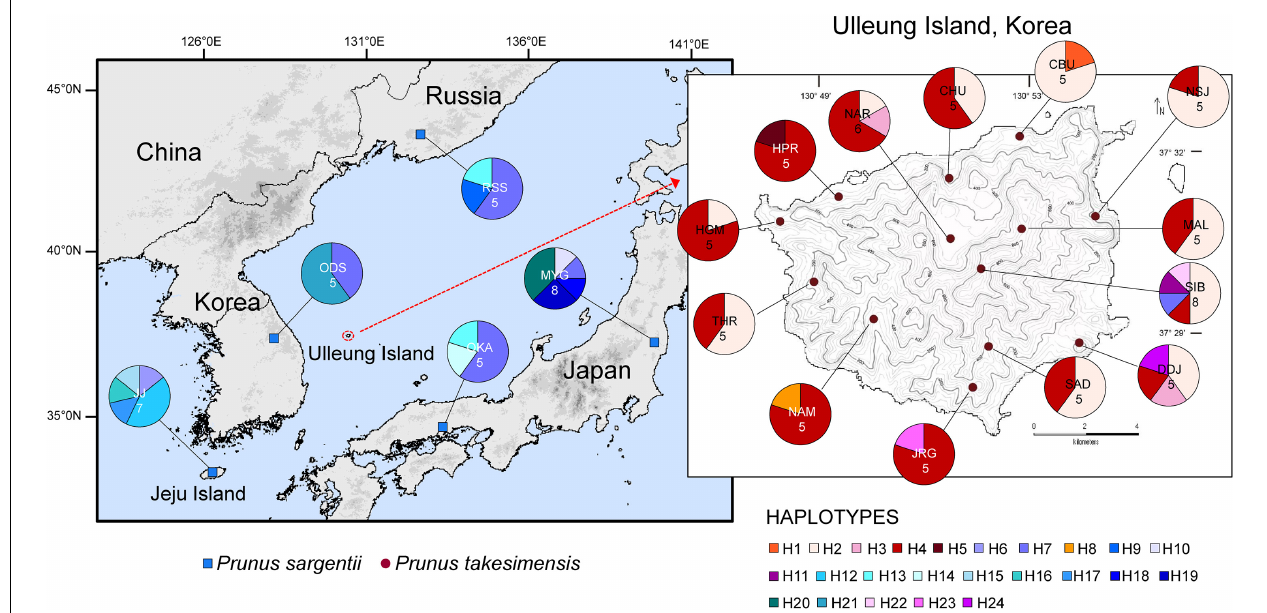
FIGURE 4 | Map of the haplotypes found in the populations of the insular derivative, P. takesimensis , and its continental progenitor species, P. sargentii , based on five non-coding regions of cpDNA. Populations are labeled with different color codes specified in Table 1 . The sampling locations are denoted in different colors: red for P. takesimensis and blue for P. sargentii. Different colored portions in each pie chart represent the haplotype